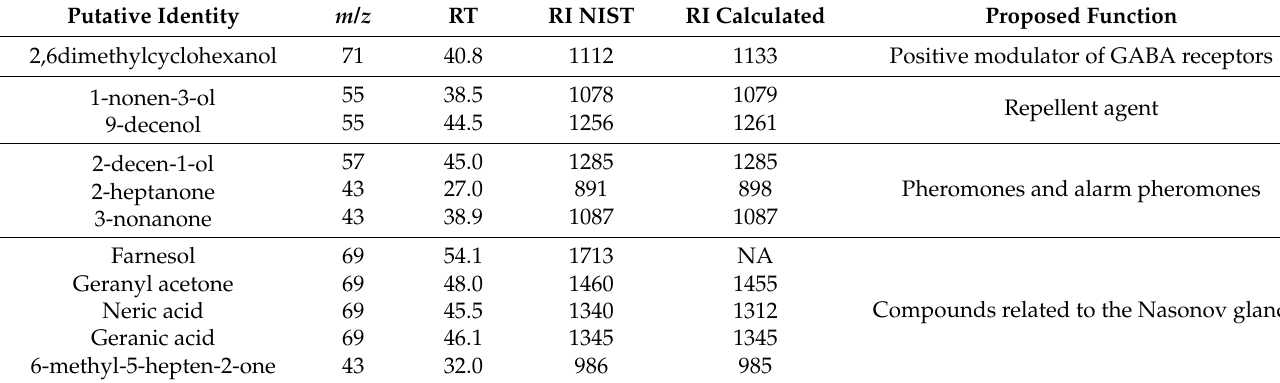
Table 2. VOCs whose signal abundance was significantly modulated in A. mellifera after 14 or 21 days of chronic exposure to fipronil. The putative identity is based on the comparison of the results obtained with the GC-MS Solution software (version 4.11 SU2, Shimadzu) and the AMDIS (Automated Mass-Spectral Deconvolution and Identification System) software (version 2.72) of the National Institute of Science and Technology (NIST). The retention times (RT) indicated correspond to those obtained with the GC column Rxi ® —624Sil MS fused silica column (60 m × 0.25 mm × 1.4 µ m, Restek). The mass/charge ratios ( m / z ) correspond to the mass fragments used for area determination. The RI NIST values correspond to the retention indices reported with a D85 capillary column in the NIST database. The function proposed for each molecule is based on searches in bibliographic databases and in specialized databases such as The Pherobase, which is specialized in compounds with semiochemical activities (https://www.pherobase.com/, accessed since January